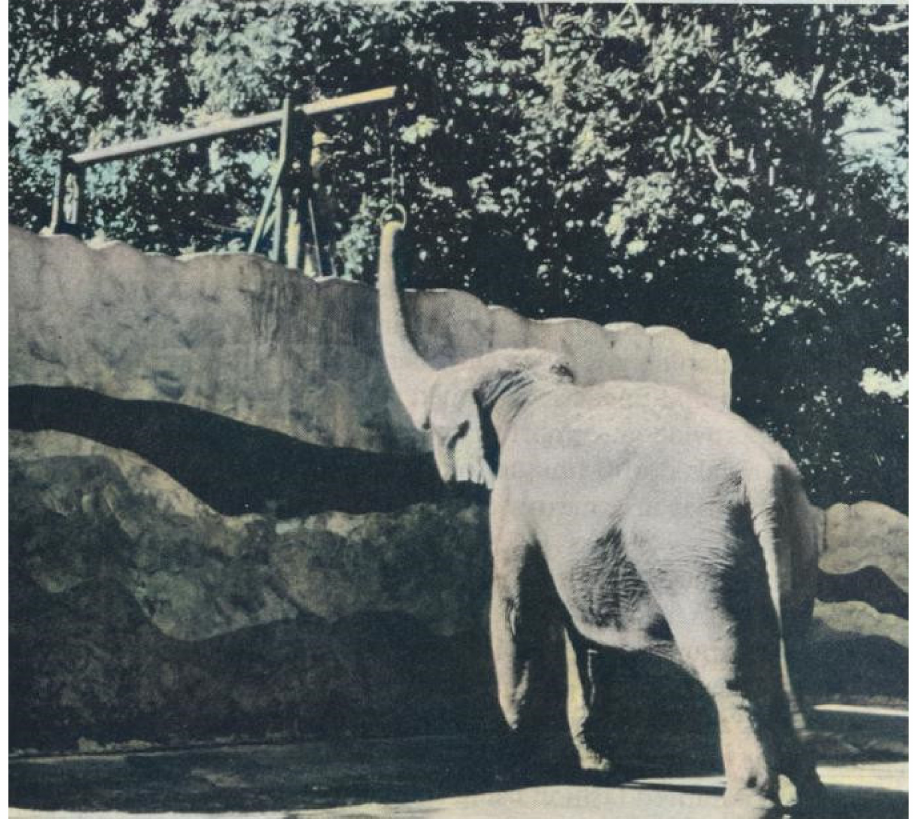
Figure 5. Colorized photo of an Asian elephant pulling a ring to obtain fruit at the Honolulu Zoo, circa late-1970s. (Reproduced from [10] with permission of John Wiley & Sons Limited,